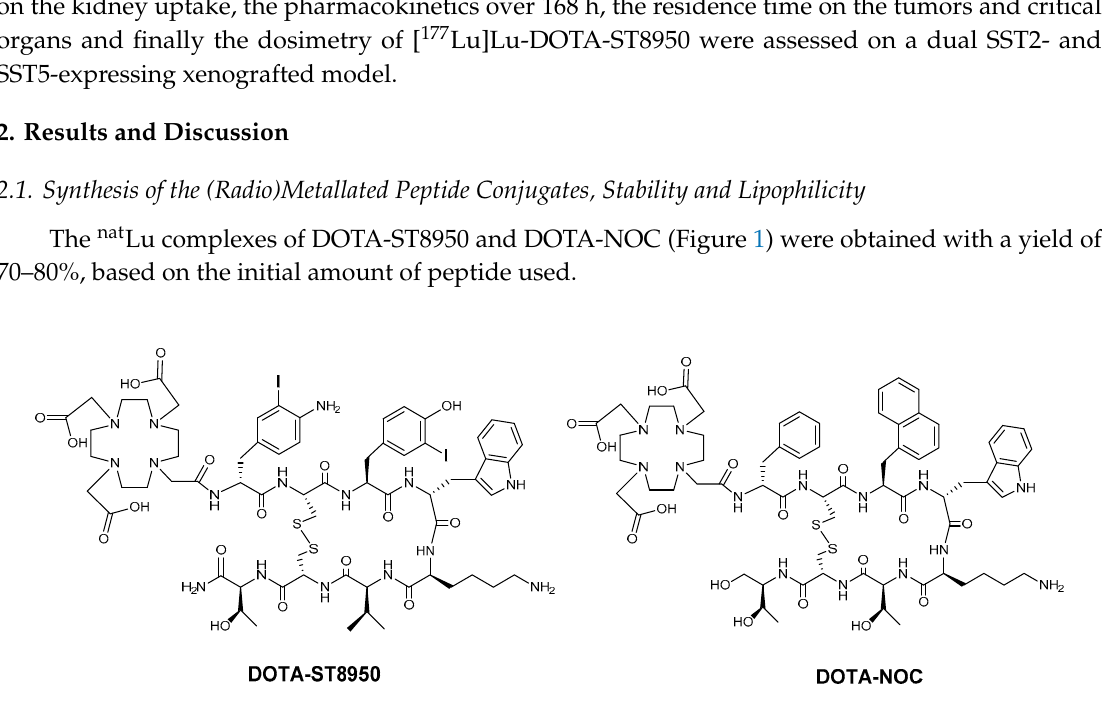
Figure 1. The structural formulae of DOTA-ST8950 (DOTA-(4-amino-3-iodo)- D -Phe-c[Cys-(3-iodo)- Tyr- D -Trp-Lys-Val-Cys]-Thr-NH 2 ) and DOTA-NOC (DOTA- D -Phe-c[Cys-1-NaI- D -Trp-Lys-Thr- Cys]Thr(ol)).